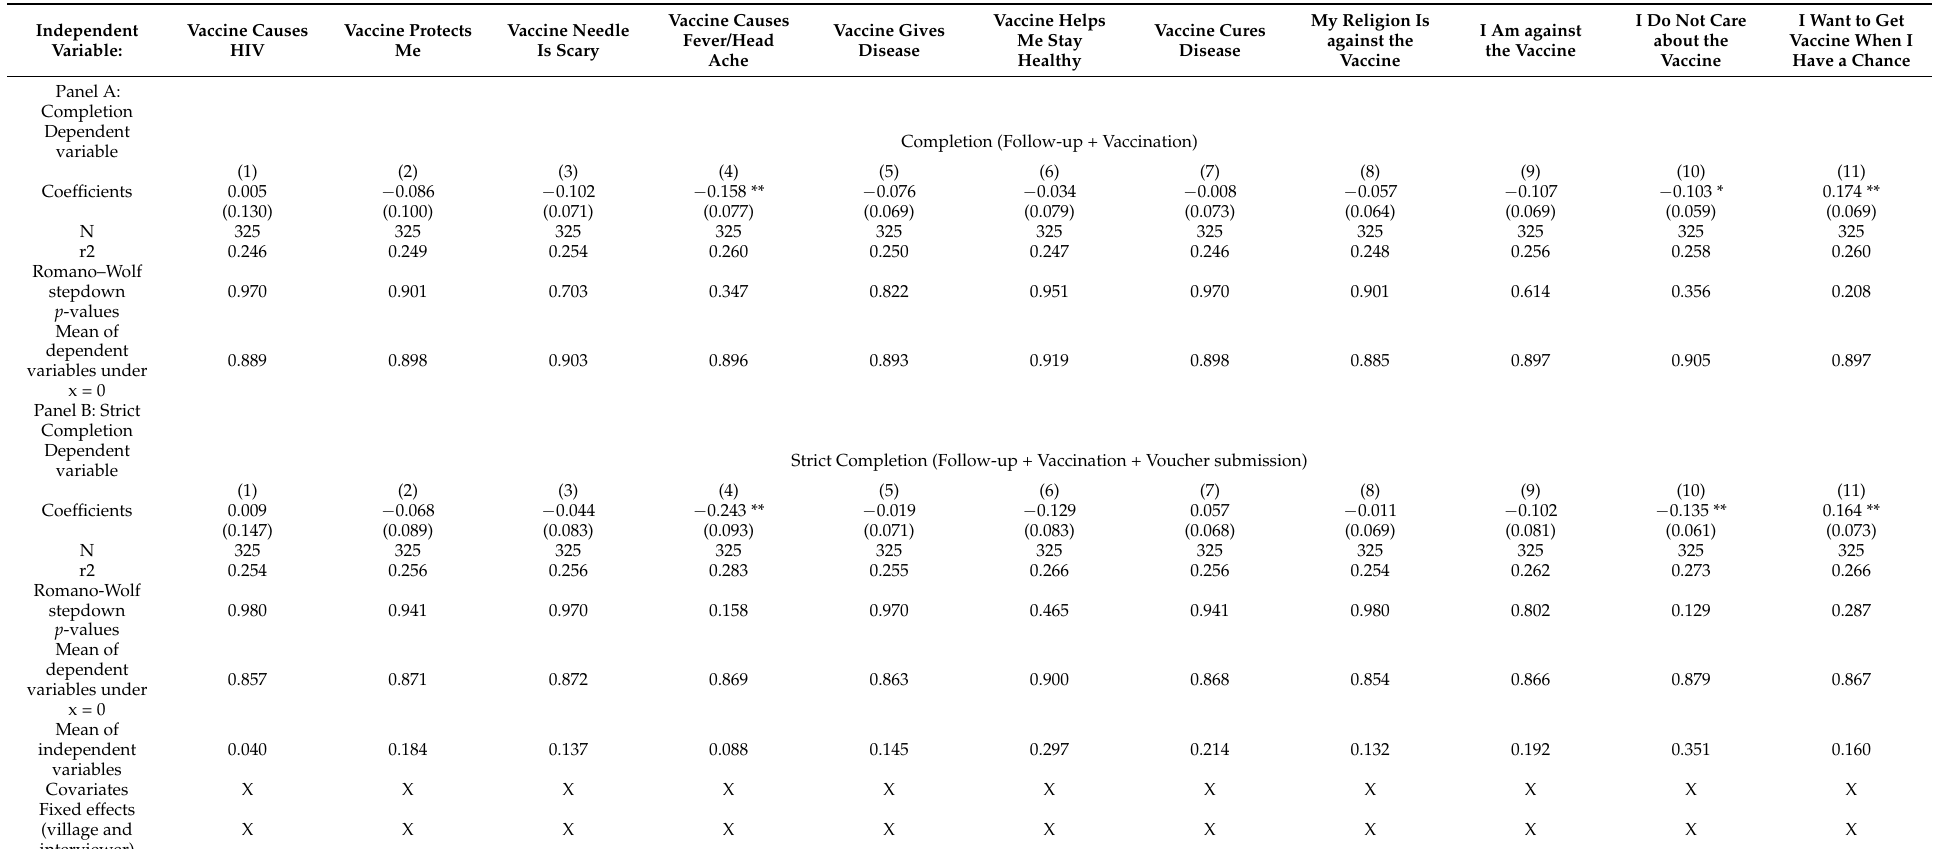
Table 8. Beliefs and vaccine take-up among treated